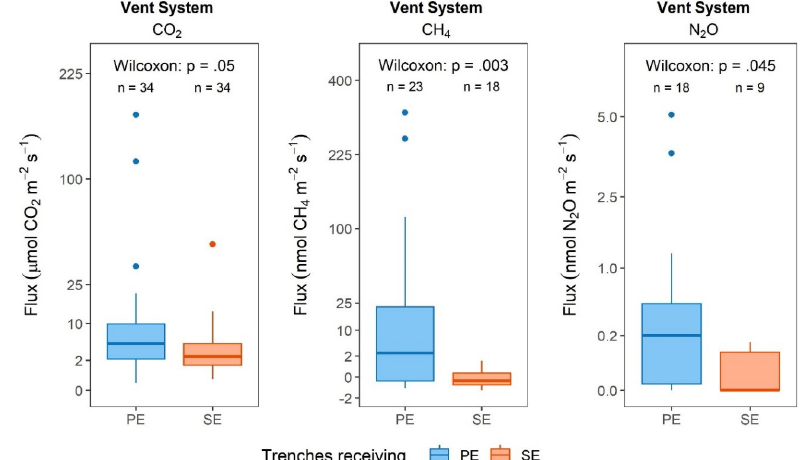
Figure 6. Boxplots of observed gas fluxes from the STU vent system for CO 2 , CH 4 and N 2 O over trenches receiving primary (PE) and secondary (SE) effluent. Statistical results are presented as the p value of Wilcoxon signed rank tests with estimated effect size r and corresponding boot-strapped 95% confidence intervals; n denotes the number of observations per group. Note that the y scale for CO 2 is given in units different from units used for CH 4 and N 2 O and that the y axis has been square-root transformed to improve data